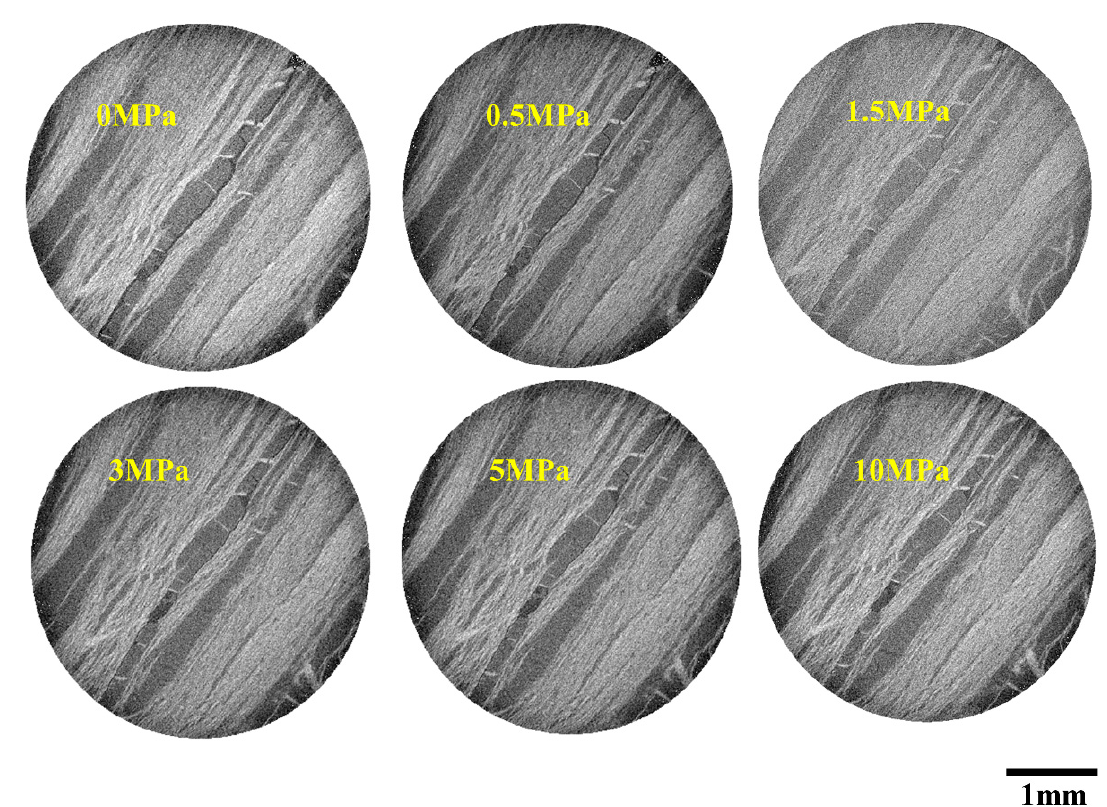
Figure 7. The 2D images of the same position in the second cycle (with the increase in confining pressure).